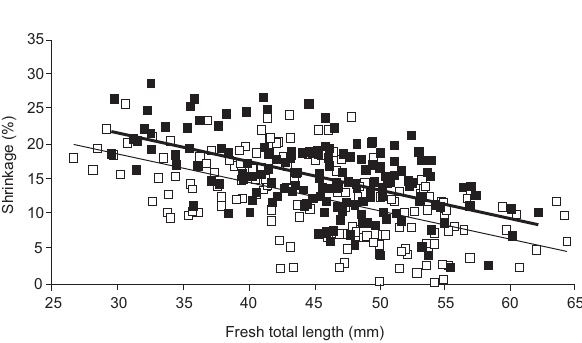
Figure 3. Shrinkage percentage in weight in relation to total length for A. brasiliensis : freshwater ( (cid:133) ) (y = -0.40x + 30.84, R 2 = 0.31), marine water ( (cid:132) ) (y = -0.41x + 33.98, R 2 = 0.29). Figure 4. Shrinkage percentage for total length in relation to total length for A. brasiliensis : freshwater ( (cid:133) ) (y = -0.25x + 21.06, R 2 = 0.33), marine water ( (cid:132) ) (y = -0.55x + 36.19, R 2 =